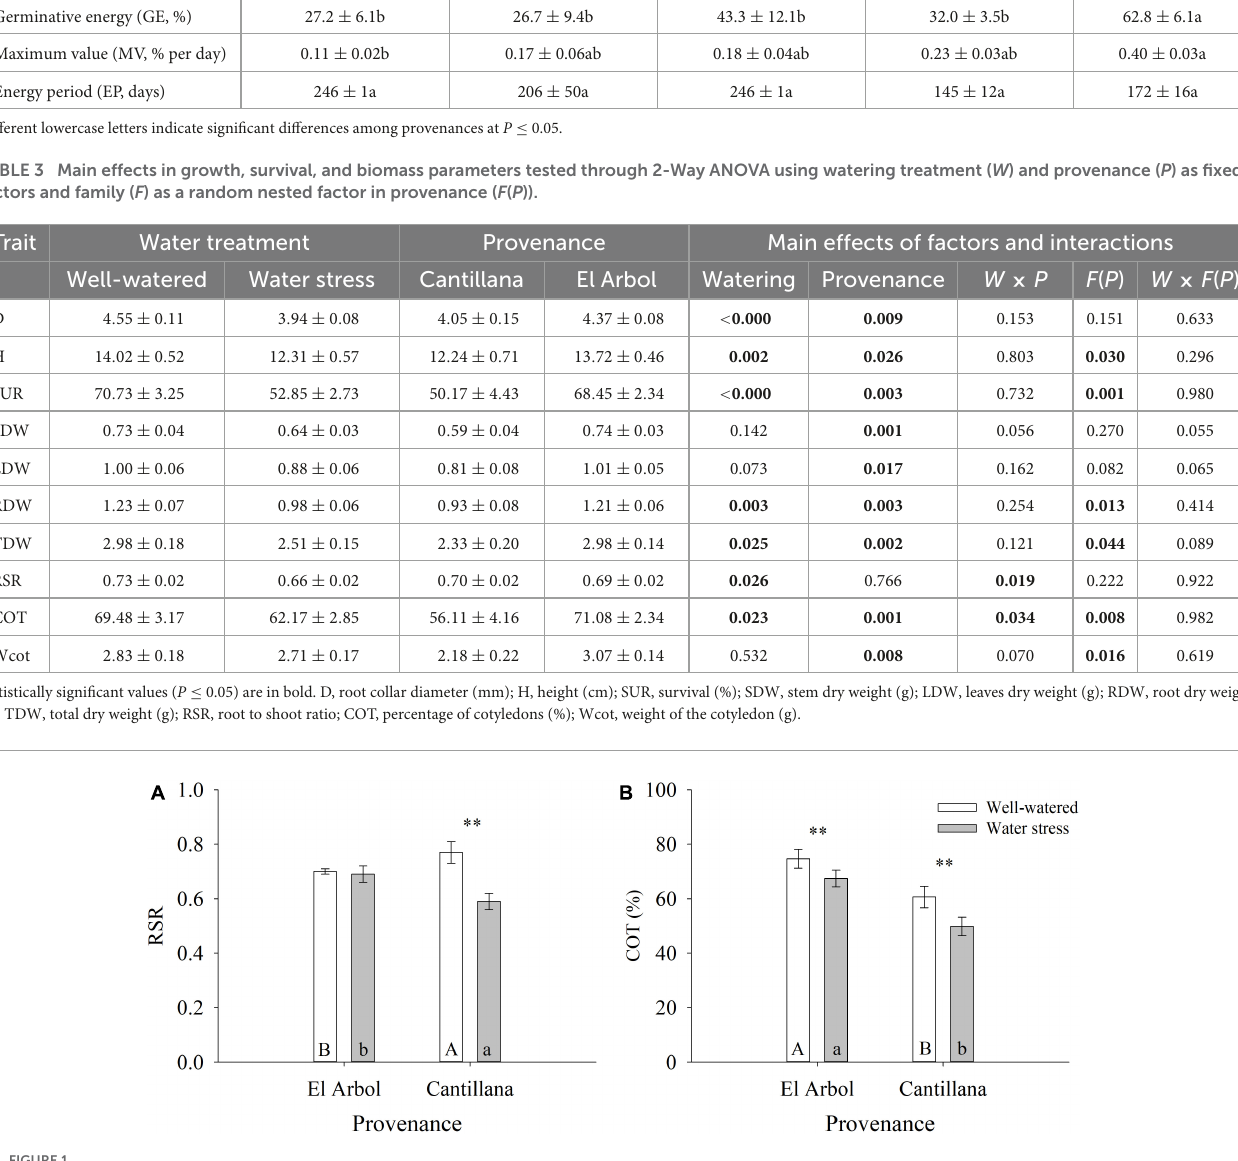
FIGURE1 Provenance variation by watering regime for RSR (A) and COT (B) . ∗∗ Indicate significant differences within a provenance at P ≤ 0.05. The same lowercase and uppercase letters indicate no significant differences ( P ≤ 0.05) between the provenances in the well-watered and water stress